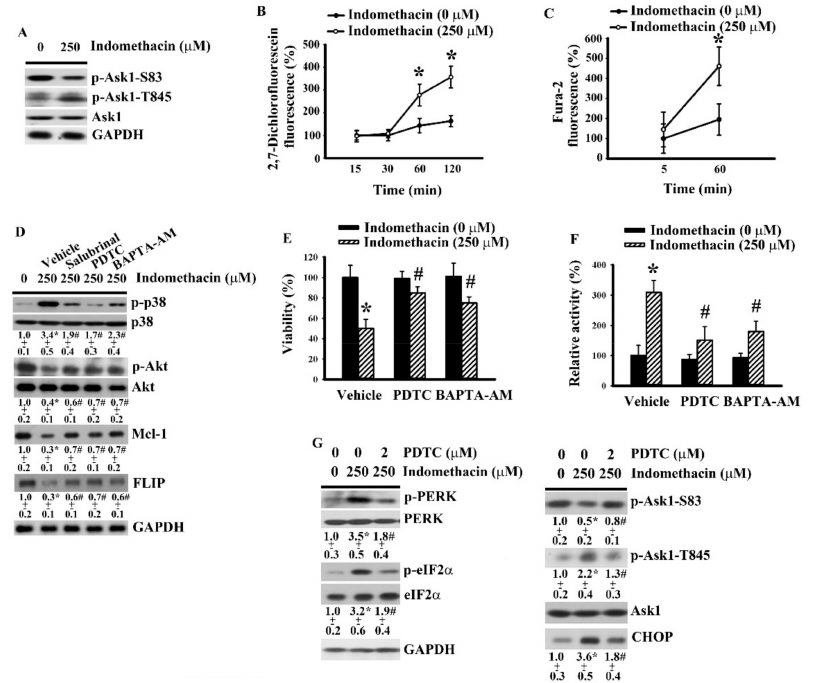
Figure 4. Indomethacin induced ER stress-related apoptotic signals in H4